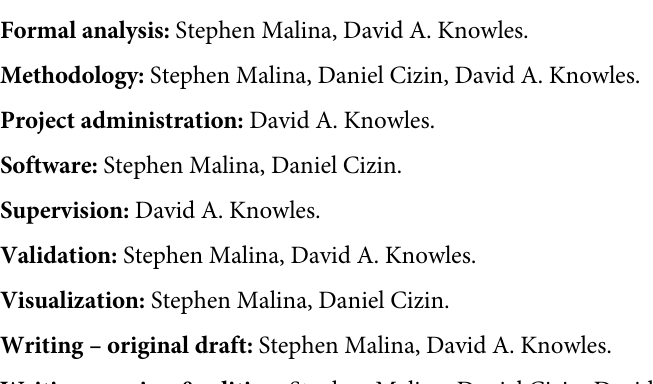
S1 Fig. Effect of motif spacing on BPNet global CEs. Heatmap of Global CEs broken down by TF pairs and motif spacing buckets. Each row represents the global effects of one TF on another, computed using a subset of sequences in which both TF’s motifs appeared within the relevant distance range of each other. The figure shows the effect of motif spacing on global CE estimates for the four BPNet TFs. To compute effects for each TF and spacing bin, we used motif instance annotations from [12] to select sequence regions with motif instance pairs. For each sequence region, we computed distances between the two motif instances. Finally, we binned the sequence regions by motif instance distance and ran DeepMR on the sequence regions within each bin for each pair of TFs to obtain global CEs. The horizontal color banding in the heatmap illustrates that, while motif spacing has some effect on global CEs, the inter- spacing differences tend to be much smaller than the inter-TF differences.